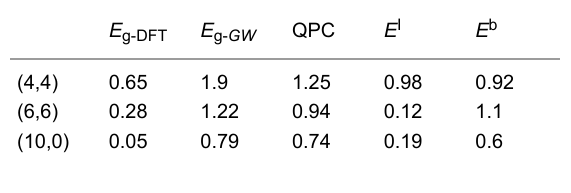
Table 1: Band gap at DFT-LDA and GW levels ( E g-DFT and E g- GW ), QP corrections to the DFT-LDA gaps (QPC), excitation energy ( E I ) and binding energy ( E b ) of the first bound exciton of silicon nanotubes. All values are in eV.